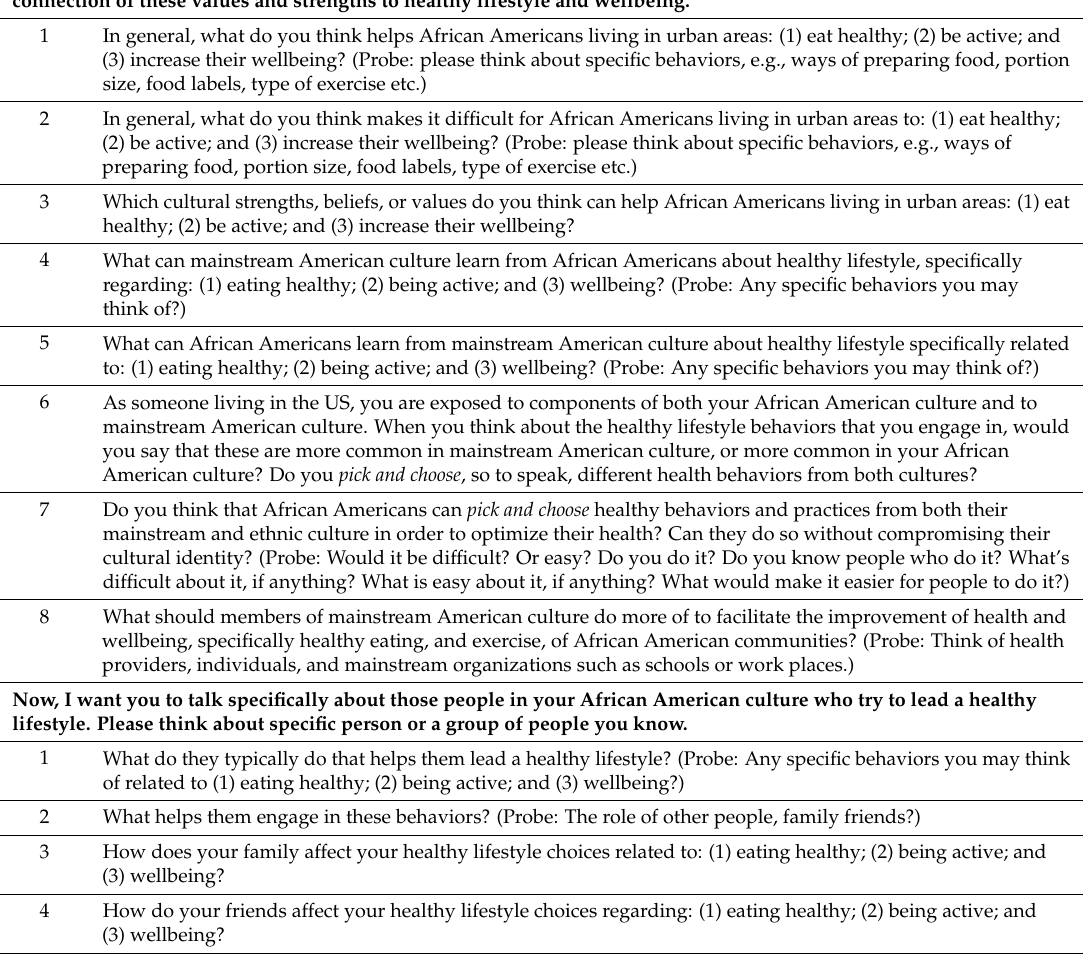
Table 2. Interview Script, Questions, and